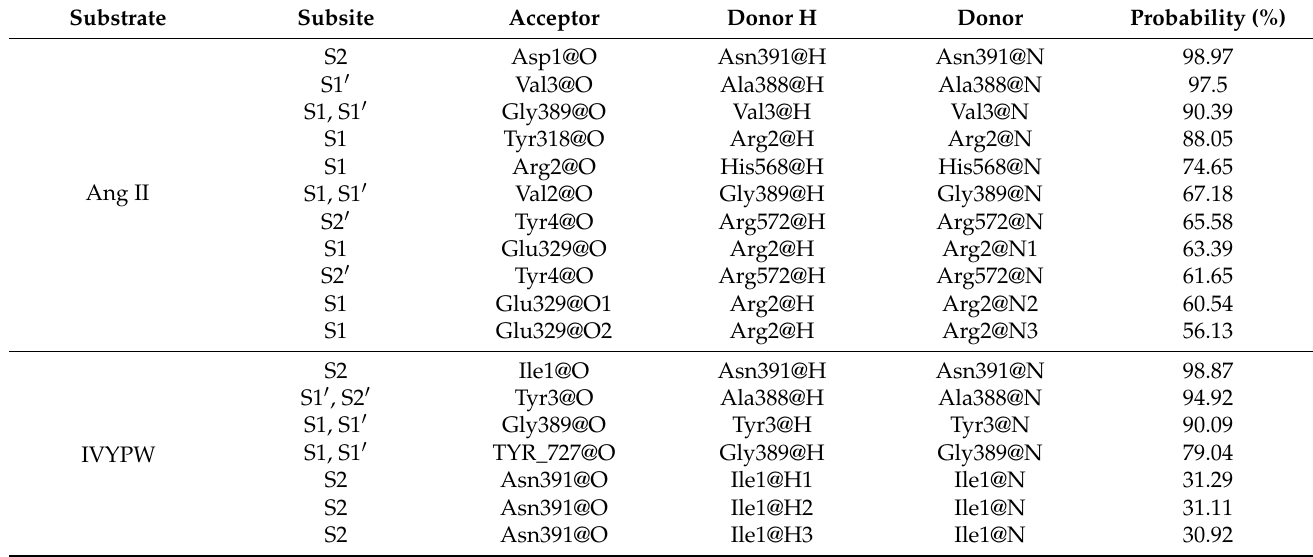
Figure 6. The distance of ( A ) Pro387-His568 ( B ) Gln-His568 of subsite S1 ′ in the three systems during 500 ns MD simulations. The surface form displays of subsite S1 ′ in ( C ) free-hDPP III, ( D ) hDPP III-IVYPW, and ( E ) hDPP III-Ang II with residues Pro387, Gln446 and His568 shown as sticks form and labeled. Table 2. Probabilities of hydrogen bonds between substrates and hDPP III during 500 ns MD simulations.